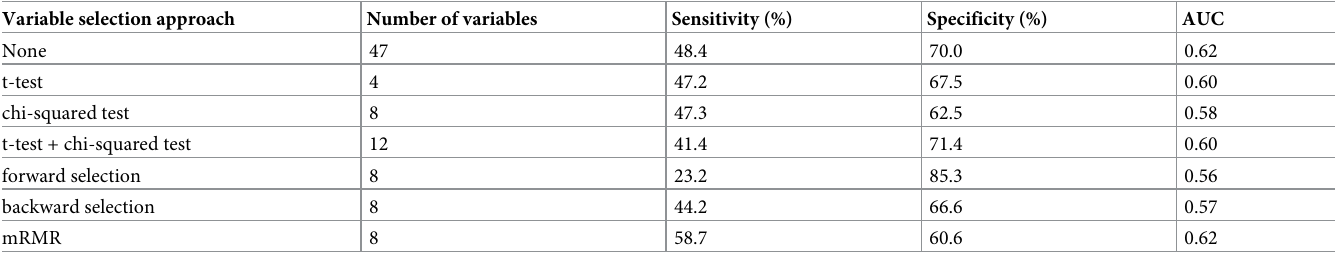
Table 4. Performance of the multi-layer perceptron prediction model for 30-day HF readmission or death in HF patients. Variable selection